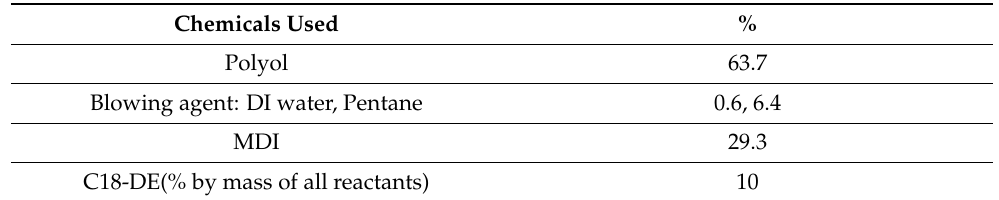
Table 1. Formulation of chemical used for